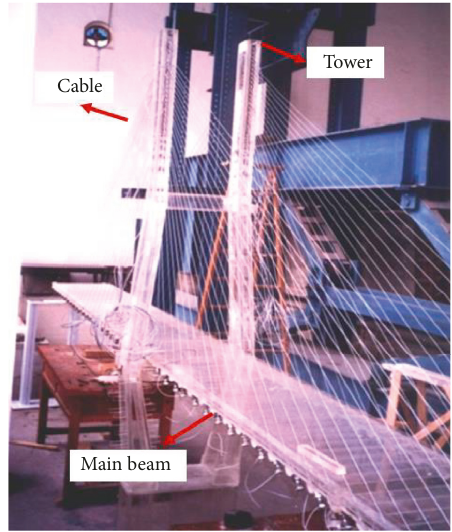
Figure 7: Experimental bridge model in hoisting